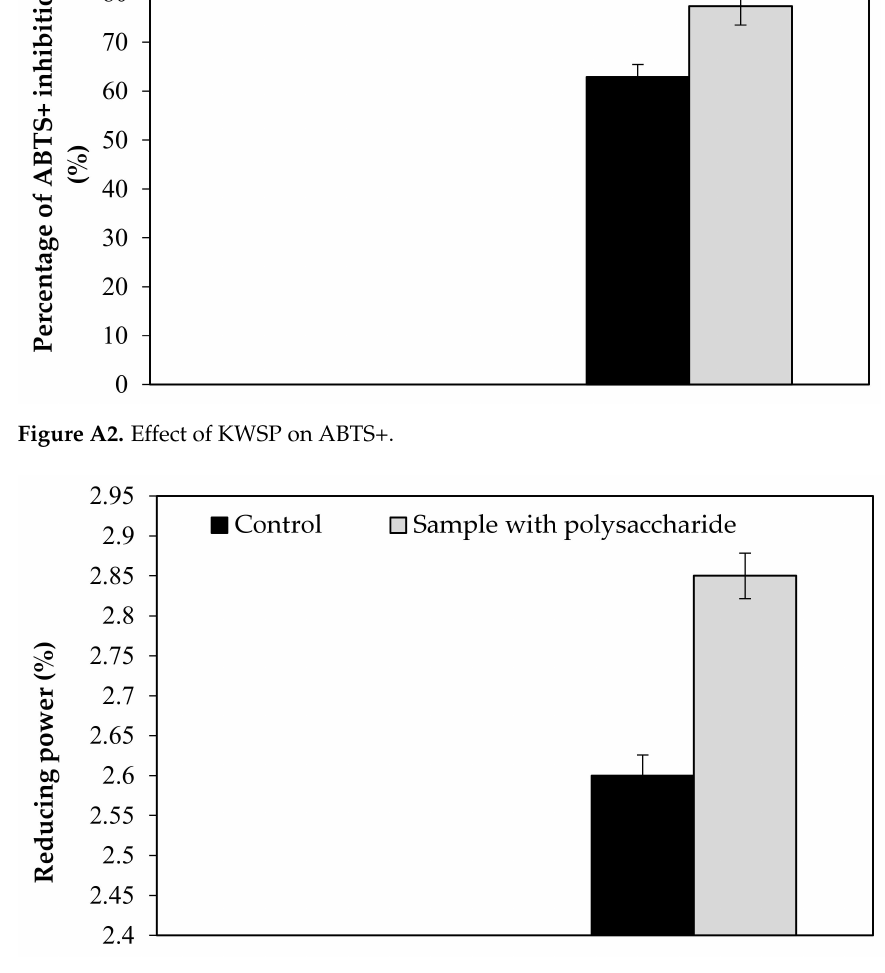
Figure A3. Effect of KWSP on reducing power.